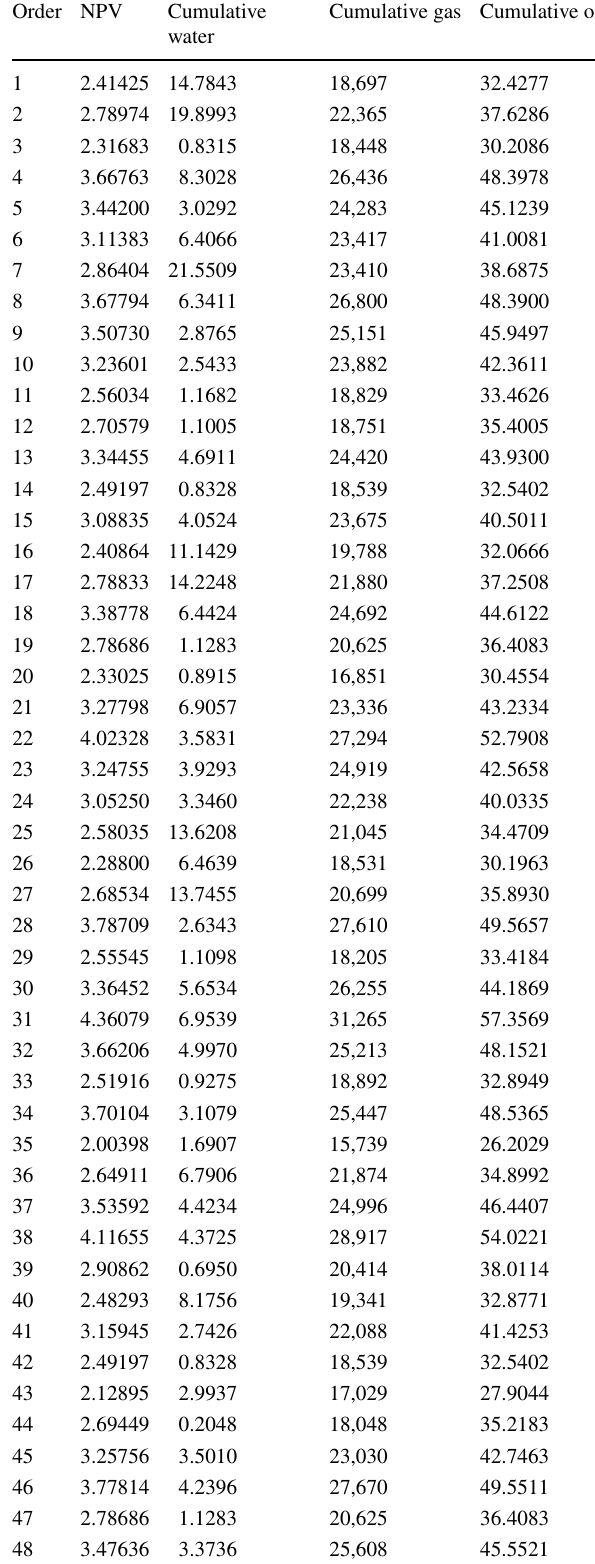
Table 13 The results of 57 test designs by the Box–Behnken method to build a proxy model Order NPV Cumulative